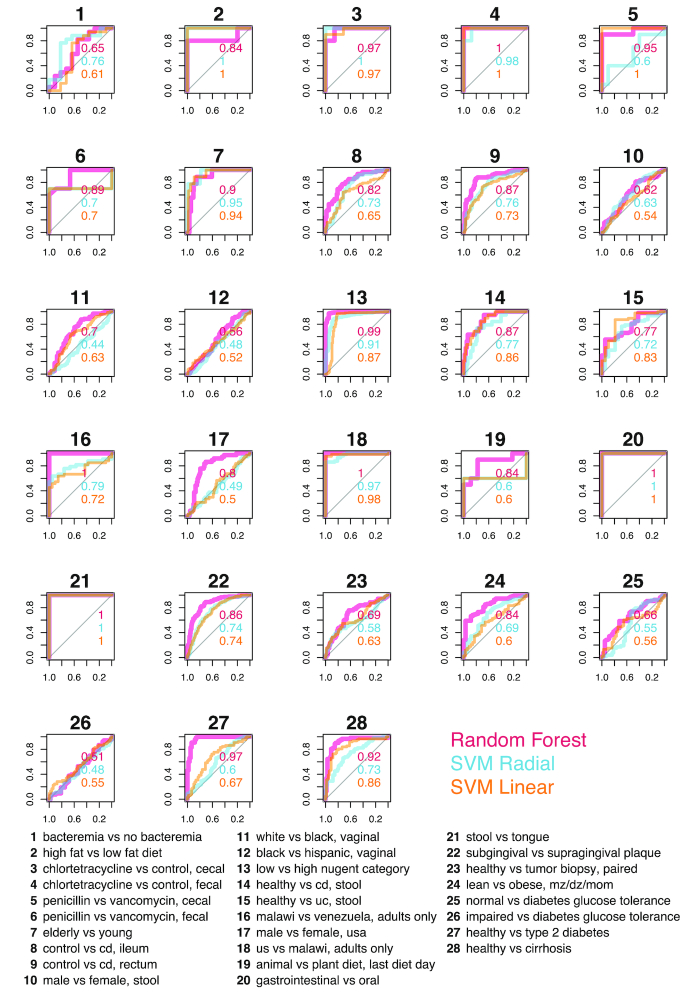
ROCs comparing random forest and SVM with different kernels. Sweeping across all binary classification tasks available in ML Repo (28), we compare ROCs of random forest, SVM with a radial kernel, and SVM with a linear kernel. AUCs are listed within plots and are colored respective to each model. cd: Crohn's disease; dz: dizygotic; mz: monozygotic; uc: ulcerative colitis.